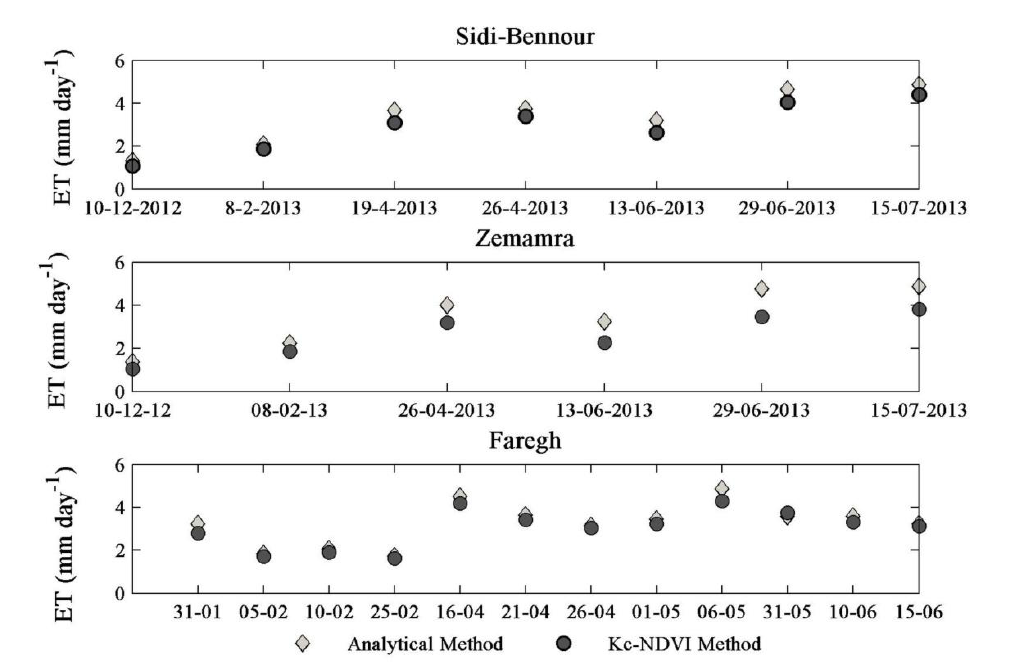
Figure 13. Comparison between daily ET analytical approach in the Zemamra, Sidi Bennour and Faregh